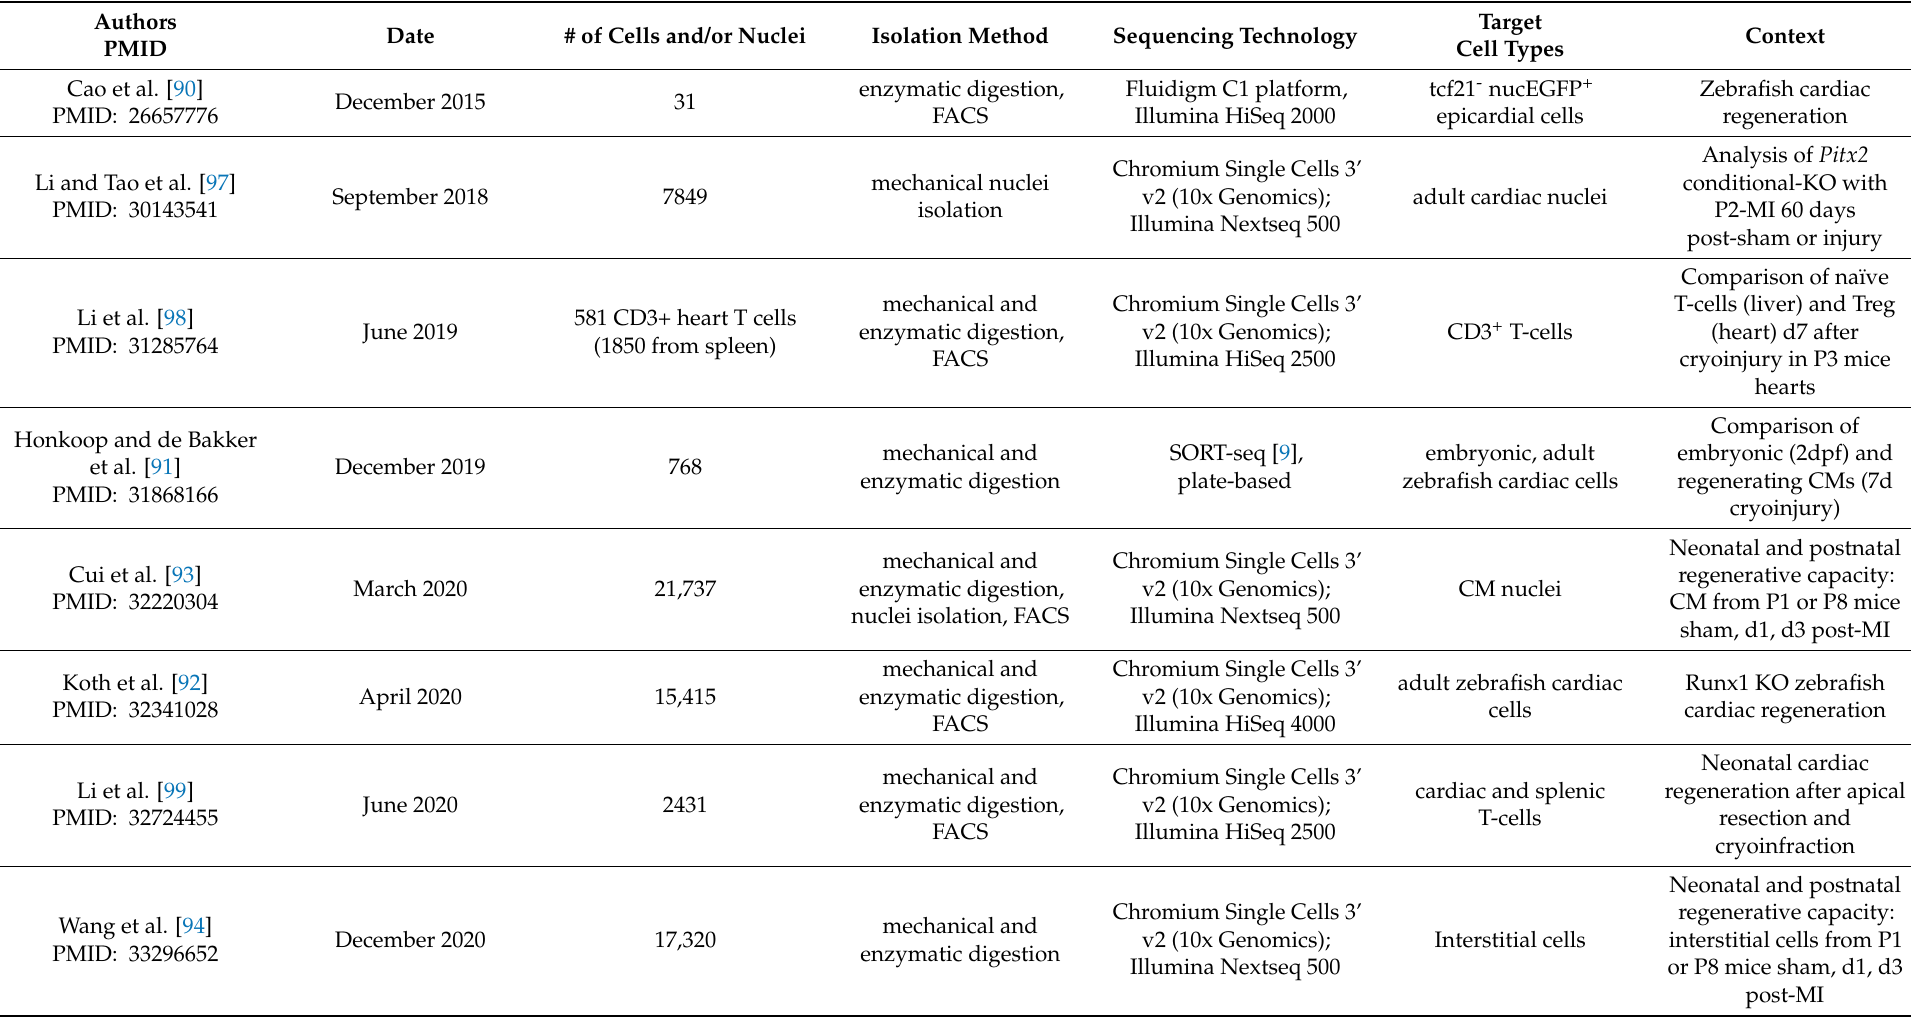
Table 4. Cardiac Injury in Regenerative